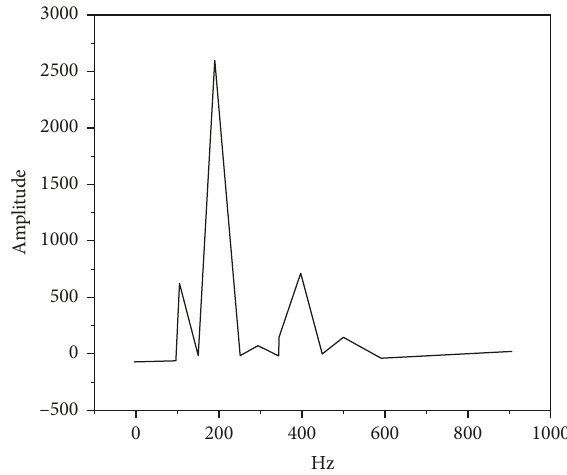
Figure 2: Spectrum lines in the frequency domain of